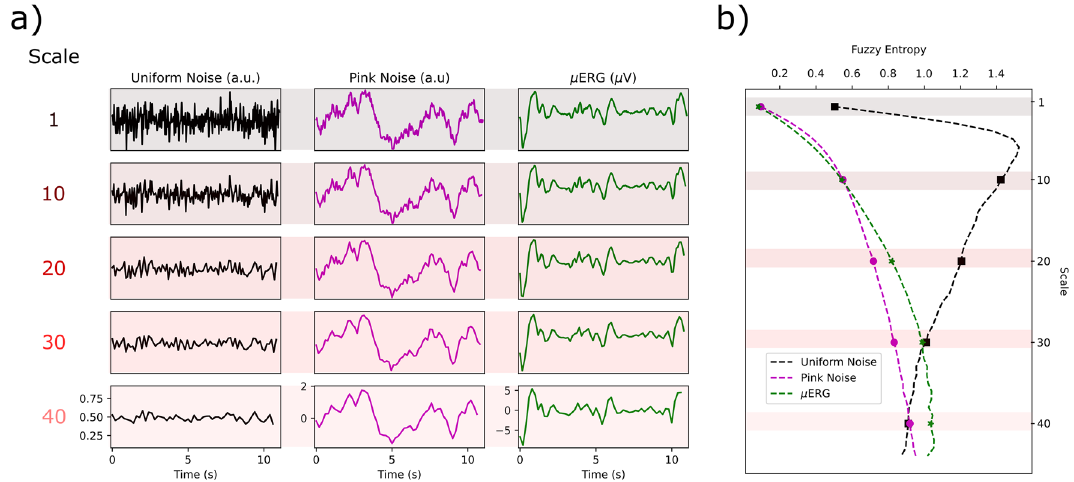
Figure 6. Illustration of the multiscale entropy (MSE) procedure. ( a ) Effect of the coarse-graining procedure on uniform noise (left), pink noise (middle) and an example µ ERG signal (right). Original signals (scale 1, top) were low-pass filtered at 30 Hz (sampling frequency 200 Hz), and the coarse-grained signals were calculated for four different scales: 10, 20, 30 and 40. The irregularity of the uniform noise signal decays for scale > 10 , whereas for the other two signals, the main irregular features persist across all scales, reflecting a more complex underlying structure. ( b ) MSE curves calculated for the signals in ( a ). The entropy for the scales shown in ( a ) are shaded. Note that for scales > 10 , the entropy of uniform noise decays monotonically, whereas for pink noise and the µ ERG signal, it